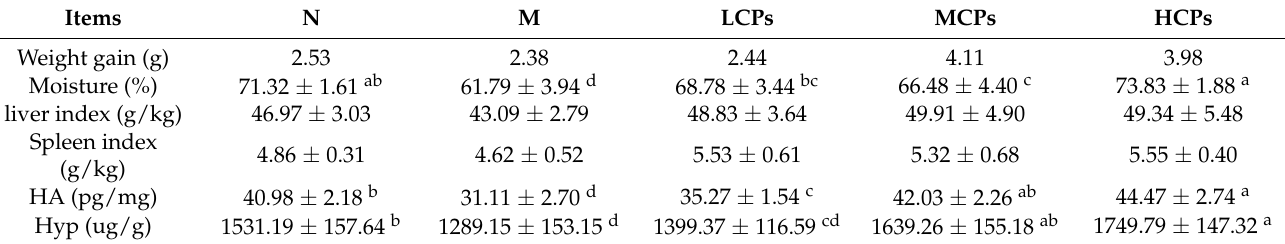
Table 2. Body-weight, organ index, and skin composition of